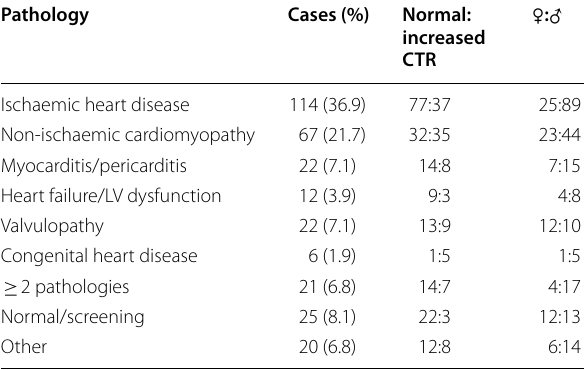
Table 1 Distribution of diagnoses and their characteristics